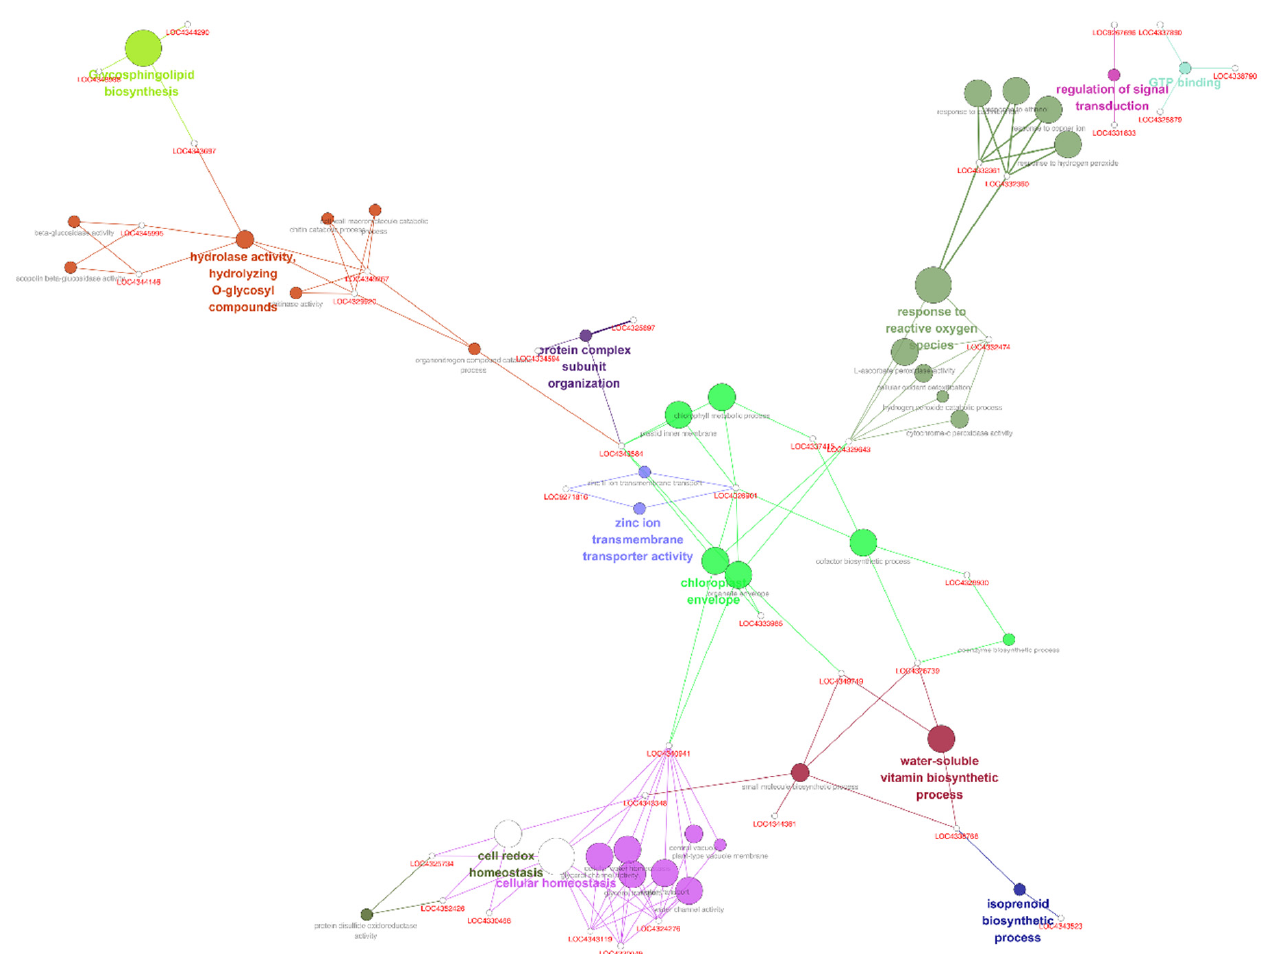
Figure 5. Genetic network of the genes upregulated in TR plants. Marked characteristics are annotated in Supplementary Table S4.